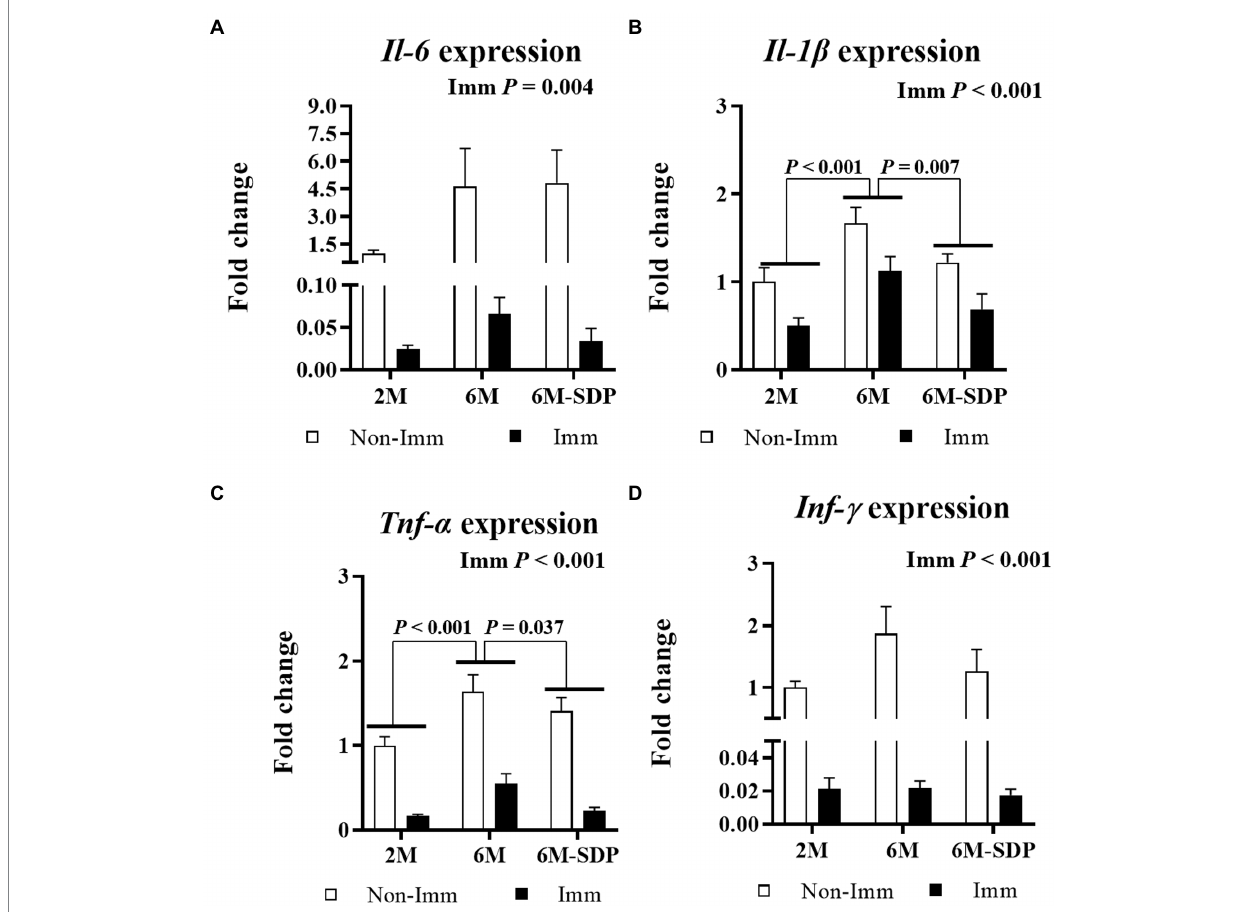
FIGURE 8 mRNA expression of Il-6 (A) , Il-1 β (B) , Tnf- α (C) , and Ifn- γ (D) in lung tissue. Open bars represent non-immunized ( Non-Imm ) mice; solid bars represent immunized ( Imm ) mice. All target genes were normalized to Gus β expression. The fold-change expression is against immunized 2 M mice. Results are expressed as means ± SEMs ( n = 9–10 animals). Statistics: two-way ANOVA (age-feed and immunization factors; Fisher multiple comparison test). Int indicates the interaction between immunization and age-feed factors. Gus β , glucuronidase beta; Ifn- γ , interferon gamma; Il, interleukin; SDP, spray- dried porcine plasma; Tnf- α , tumor necrosis factor